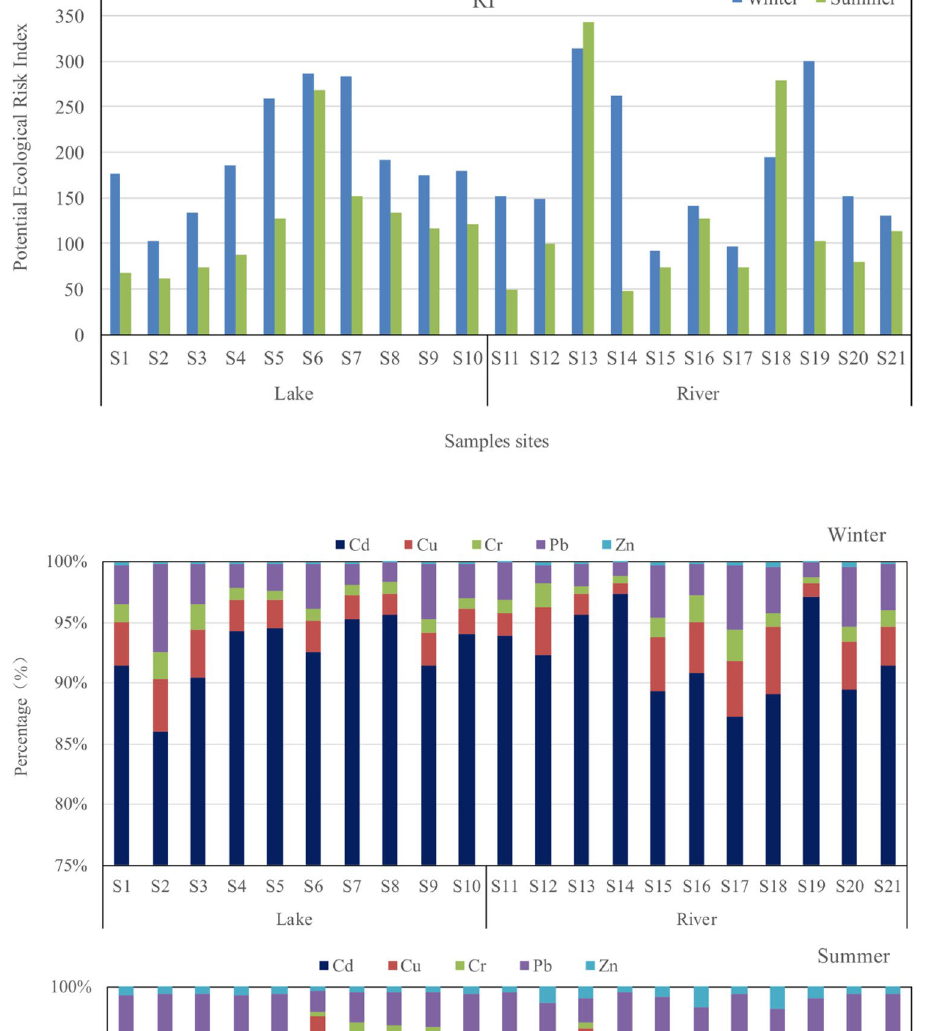
Fig. 6 The potential ecological risk index